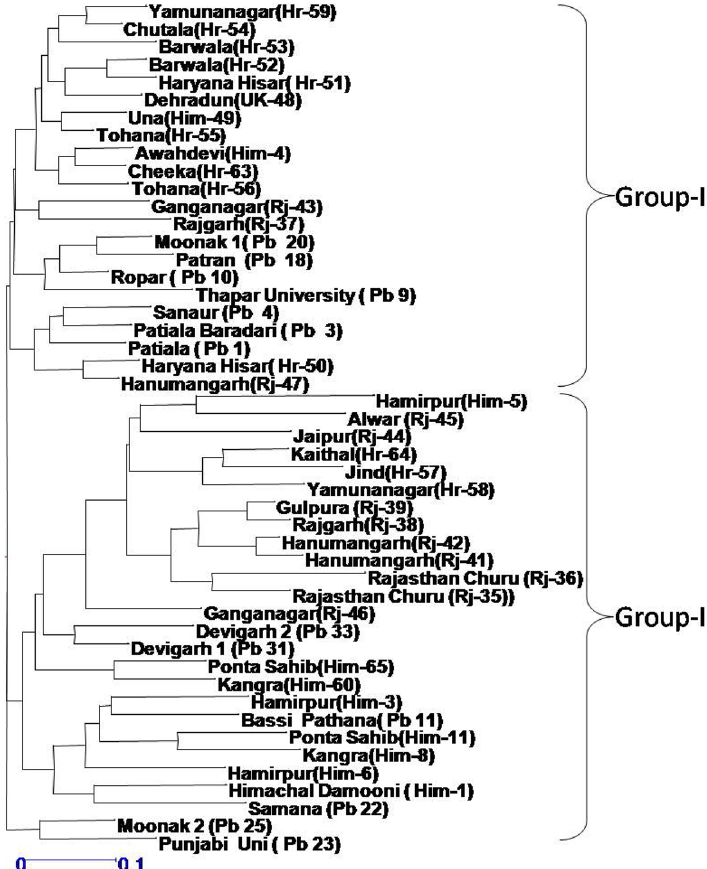
Fig. 2 Dendrogram of 48 Ziziphus accessions based on 23 SSR markers data showing clustering of all accessions into two major